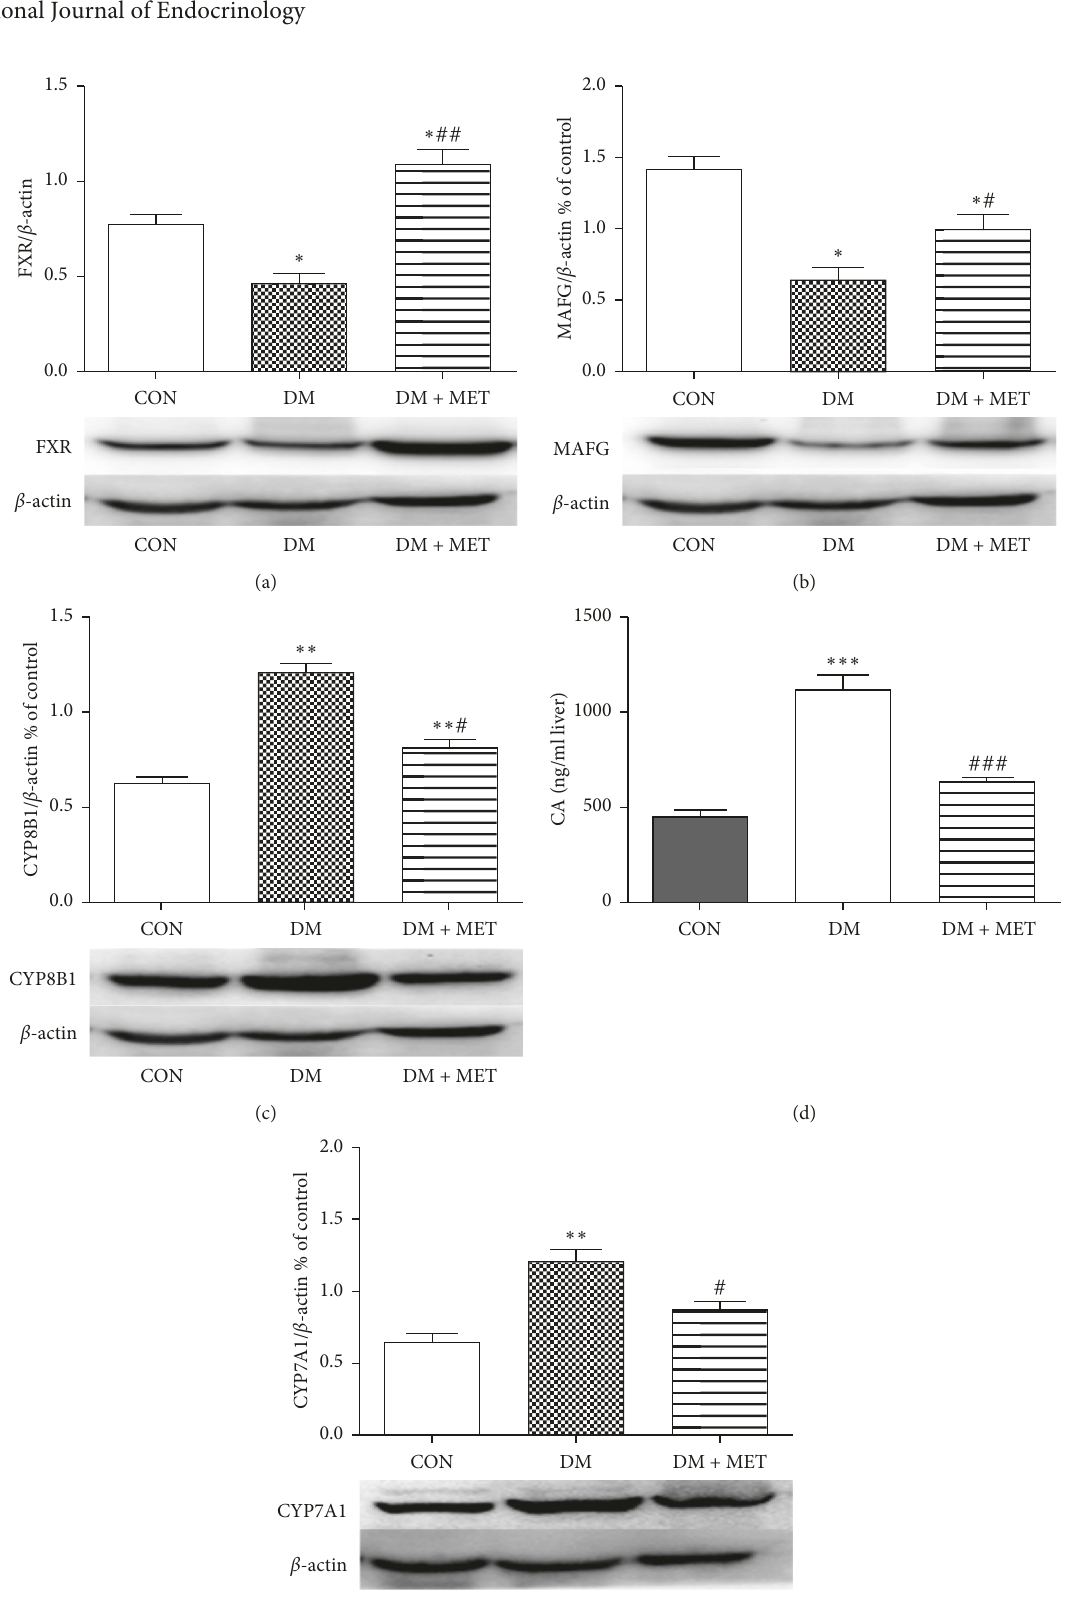
Figure 3: Effects of metformin on FXR, MAFG, CYP8B1, and CYP7A1 in liver tissue induced diabetes in Wistar rats. Protein contents were detected by western blotting. FXR (a), MAFG (b), CYP8B1 (c), and CYP7A1 (e) in liver tissue were quantified using Image J. The data shown represents 3–5 independent experiments. ∗ Mean values were significantly different ( p < 0 . 05) compared to CON rats. # Mean values were significantly different ( p < 0 . 05) compared to DM rats. (d) The content of cholic acid in liver tissue was determined by ELISA. Data are expressed as mean ± SEM ( ∗∗∗ p < 0 . 001, ### p < 0 .